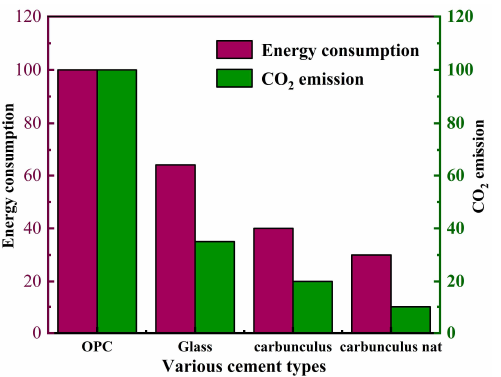
Figure 1. Comparison of energy consumption and CO 2 emissions between ordinary Portland cement and geopolymer.